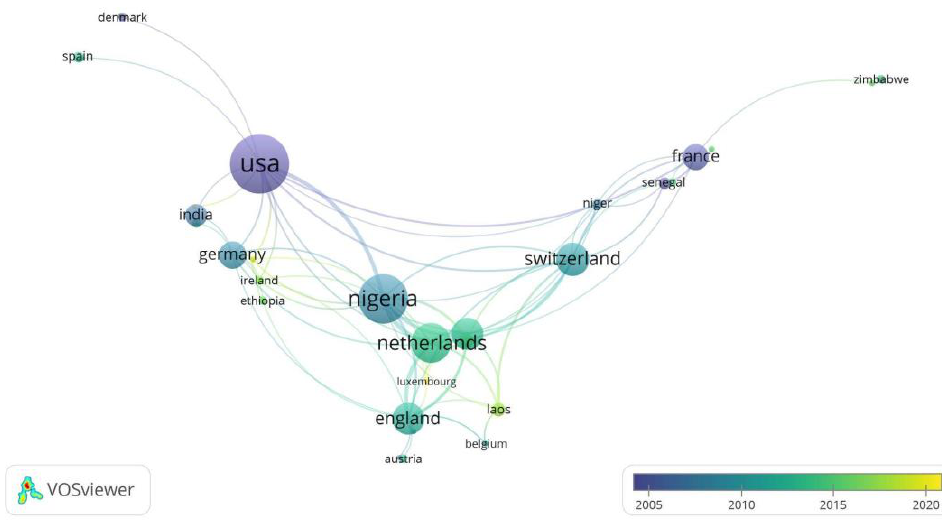
Figure 4. Network analysis of country co-authorship.